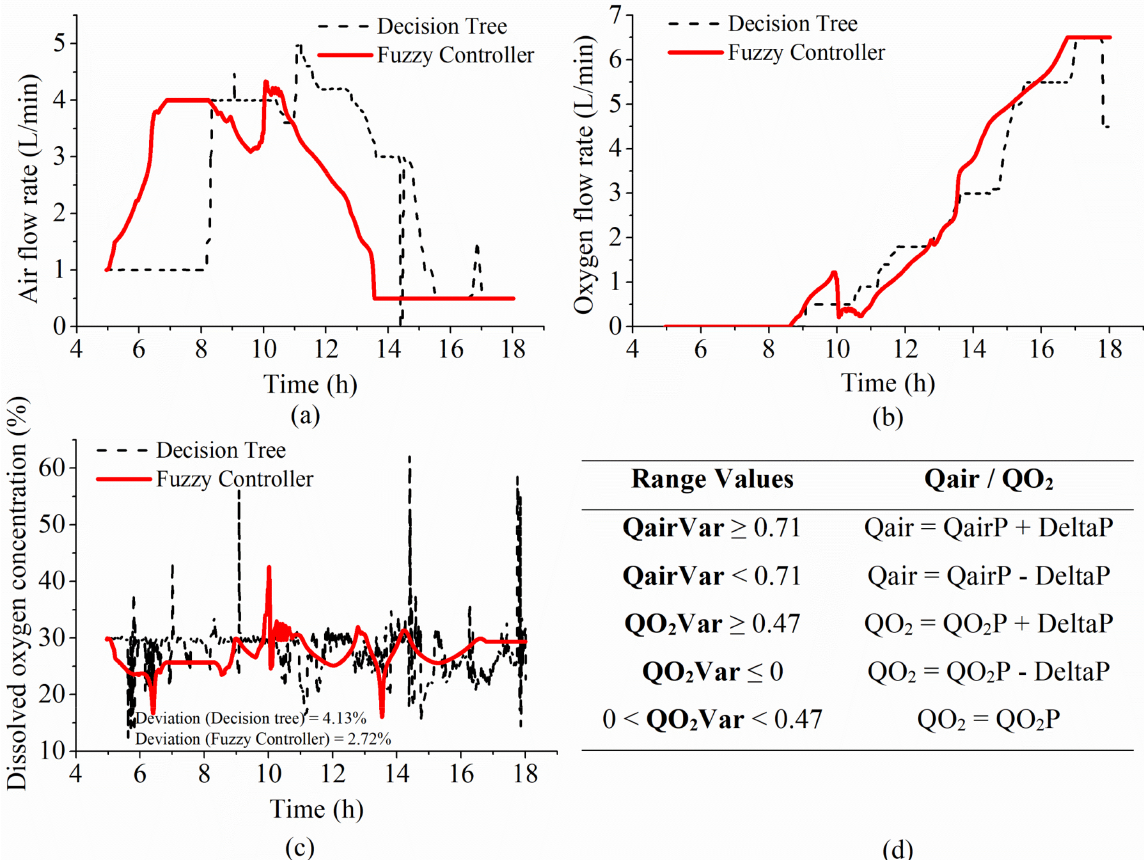
Figure 6. Simulation results for DOC fuzzy control using the simulator. The dashed line represents previously controlled cultivation data using the decision tree, whereas the solid line represents the simulated process, controlled by the fuzzy controller. Dynamics of air ( a ) and oxygen ( b ) flow rates comparing both controllers, dissolved oxygen results during fuzzy control compared with the decision tree ( c ), and limits for comparing QairVar and QO 2 Var to appropriate range values ( d ) to analyze if maintaining, increasing, or decreasing the previous QairP and QO 2 P flow